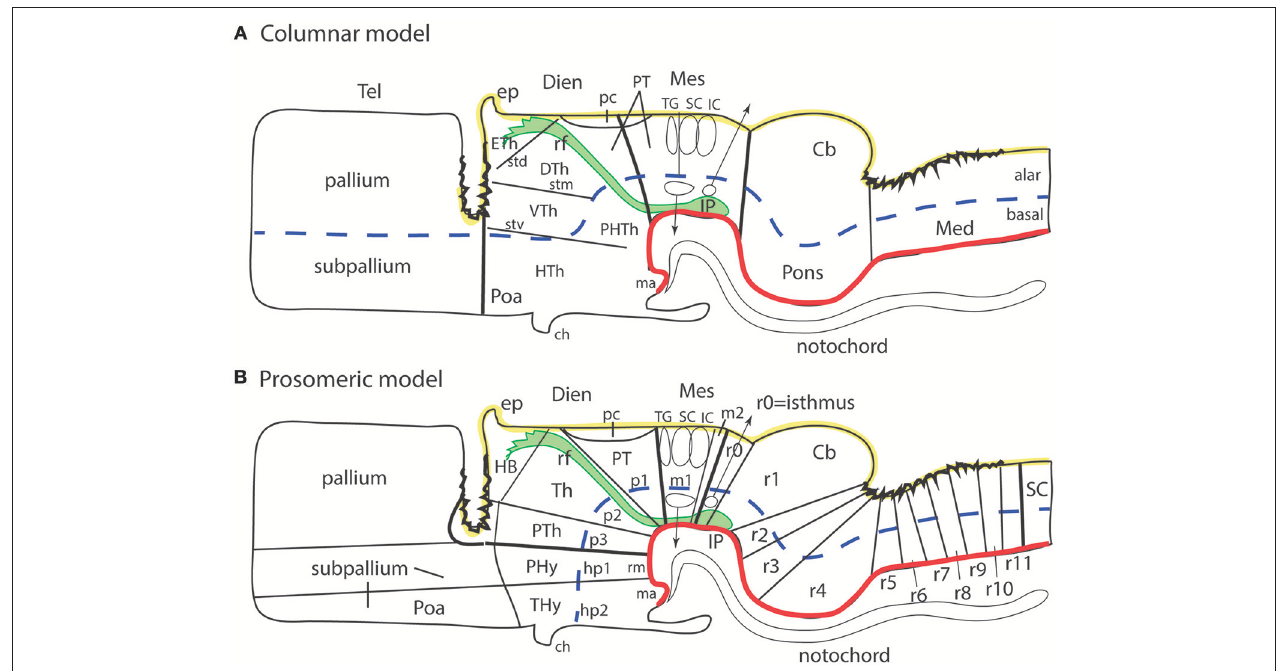
FIGURE 1 | Schematic comparison of the columnar and prosomeric models (original drawing). The same basic drawing shows in both cases telencephalon (Tel), diencephalon (Dien), mesencephalon (Mes), cerebellum (Cb), pons, and medulla (Med), as well as the notochord, the floor plate (as defined molecularly and by a glial palisade; in red), the roof plate inclusive of chorioidal plexi yellow background with black irregular domains, and the alar-basal boundary (thick blue dash line), which divides the alar and basal longitudinal zones. The retroflex tract descending from the habenula to the interpeduncular nucleus (rf, IP; green) is also depicted. Differences between the two schemata refer to the boundaries limiting large regions one from another (thick black lines) and boundaries separating subdivisions (columns or neuromeres), representing either ventricular sulci or ridges (thin black lines). (A) Columnar model: Here I used the recent version of the columnar model used by Swanson (2012), because he reasonably accepts a bending of the alar-basal boundary around the cephalic flexure (see blue dash line and its curve parallel to the floor in red); this axis landmark later ascends arbitrarily in front of the ventral thalamus (VTh) into the telencephalon, separating there pallium from subpallium. Note this model includes a tegmental posterior hypothalamus that reaches the midbrain next to the retroflex tract (PHTh), and expands rostrally into the standard hypothalamus (HTh). This model divides the hindbrain merely into medulla and cerebello-pontine complex. The midbrain is larger in this model, because it encompasses isthmic and prepontine formations caudally (including the trochlear nucleus/nerve and the interpeduncular complex; IP), and pretectal formations rostrally (caudal half of pretectum rostral to the tectal gray (TG), and the parvocellular red nucleus -not shown). Note the rostral midbrain limit passes through the middle of the posterior commissure (pc) and is not strictly transversal ( = outdated His (1893) limit; compare Figure 2A ). This model does not postulate a specific limit between the pretectum and the dorsal thalamus and epithalamus, but other columnar sources accept it passes behind the retroflex tract (rf). The columnar diencephalic subdivisions show parallel sulci thalami medius and ventralis (stm, stv) which delimit HTh, VTh, and DTh. The std (sulcus thalami dorsalis) separates DTh from epithalamus (ETh), but it does not course parallel to the others. The topological relationship of these sulci relative to the axial landmark (blue dash line) is variable: the std is parallel to it, thus being the only truly longitudinal diencephalic sulcus in this model; the stm is orthogonal to the axis, while the stv can be seen as parallel to the axial reference ascending into the telencephalon, or as orthogonal to the sulcus limitans. Inconsistently with the supposed longitudinal nature of the DTh and VTh columns, the schema shows that they reach the roof plate at one end and point into the floor plate at the other end. This is why authors such as Kappers (1947) interpreted these “columns” as transversal domains (see Figure 6A ). The hypothalamus extends beyond the rostral end of the epichordal floor plate at the mamillary body, so that it needs ad hoc causal underpinnings for justifying the implied more rostral extent of dorsoventral patterning. (B) Prosomeric model: All the neuromeric units are included, highlighting their regular topology with regard to the floor plate (red), the alar-basal boundary (blue), and the roof plate (yellow; note the roof plate extends farther in the telencephalon, along the commissural septum, finally building a roof for the preoptic area (Poa) at the anterior commissure level; this telencephalic roof relationship is also incongruent with the columnar axial concept). The prosomeric model recognizes many more subdivisions in the brainstem, and notably ascribes the pons (r2-r4) to different rhombomeres than the cerebellum (r0, r1), as indicated by fate mapping. The prepontine hindbrain (r0, r1) is thus distinguished from the midbrain, which consequently results reduced in size and contents. The rostral midbrain limit passes behind the posterior commissure. Note the interpeduncular complex now lies in the prepontine hindbrain (IP). The m2 mesomere represents the novel preisthmus concept. As regards the diencephalon, it can be easily seen that basically the same regions are interpreted in a different and more solid topologic framework supported by gene expression patterns. There appears a diencephalic tegmental (basal) region, which contains part of the mesodiencephalic substantia nigra and ventral tegmental area. The hypothalamic floor is restricted to retromamillary and mamillary subdomains (rm, ma). The entire forebrain complex, from secondary prosencephalon to caudal midbrain, is divided into alar and basal